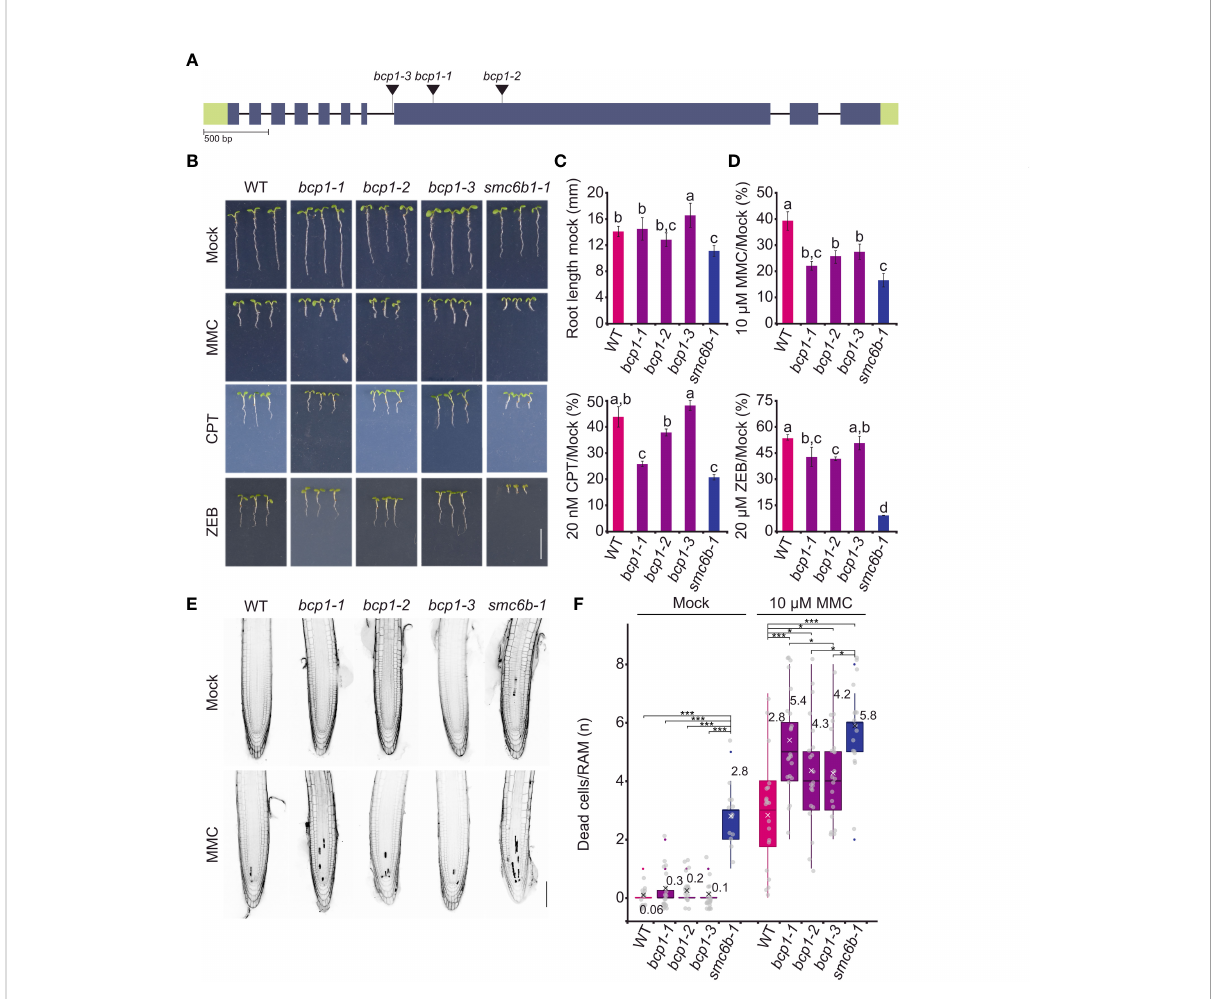
FIGURE 4 BCP1 is required for normal resistance to DNA damaging treatments. (A) Gene model of BCP1 with indicated positions of all used T-DNA insertional mutants. The style follows the description in Figure 2A. (B) DNA damage sensitivity assays of different bcp1 alleles. Representative phenotypes of seven days old wild-type (WT) and homozygous mutant plants grown on media containing 20 m M zebularine (ZEB), 10 m M mitomycin C (MMC), and 20 nM camptothecin (CPT). The smc6b-1 served as a sensitive control. Scale bar = 1 cm. (C) Root length of WT and mutant plants grown under control (mock) conditions. Error bars indicate the standard deviation between the means of nine biological replicates. The letters above columns indicate similarity between samples. The same letters indicate samples that were not signi fi cantly different in one-way ANOVA with posthoc Tukey ’ s test (P < 0.05). (D) Root length of WT and mutants under DNA damaging treatments relative to the growth of the same genotypes under mock conditions. Statistics were performed as in (C) . (E) Representative confocal microscopy images